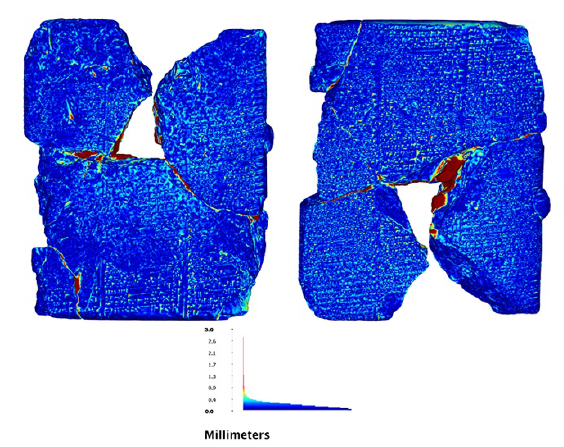
Figure 3. Color representations of Hausdorff distance calculated from the structured light 3D model to the triangulation laser scanner 3D model.